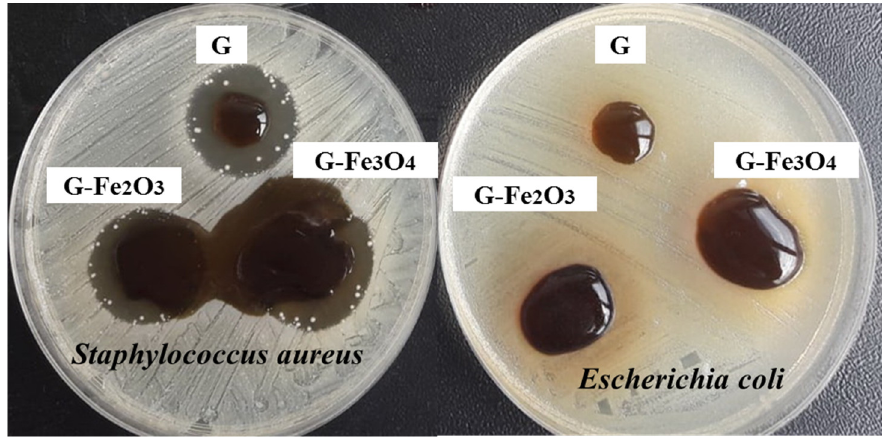
Figure 10. The antibacterial activity of the gelatin-based samples against S. aureus and E. coli. The antimicrobial activity was interpreted by comparing the average inhibition diame- ters obtained after the triple test (Table 6). Because the antibiotic sensitivity of the selected reference bacterial strains is known, we chose gentamicin (10 µ g) as a positive control [117]. Table 6. Values of the inhibition zones (mm) for the investigated